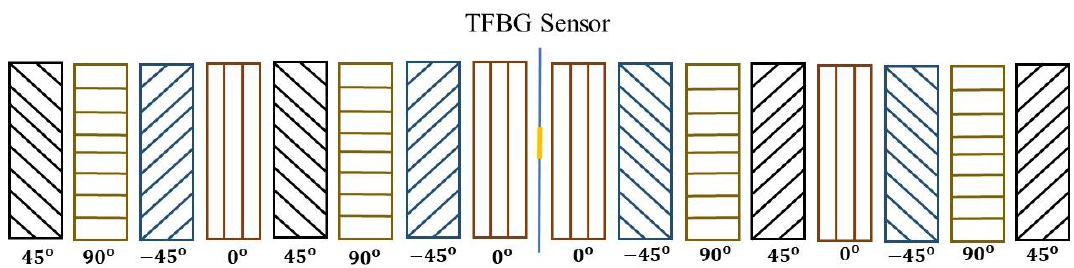
Figure 3. Layer directions of prepreg materials and TFBG sensor locations.